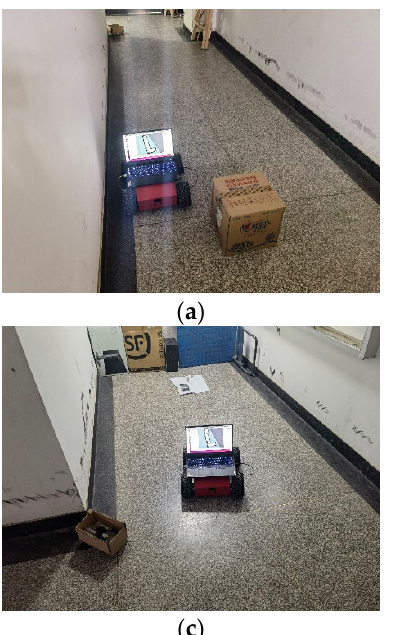
Figure 24. Navigation experiment. ( a ) Start navigation; ( b ) Detect the obstacle; ( c ) Avoid the obstacle; ( d ) Reach the target point.